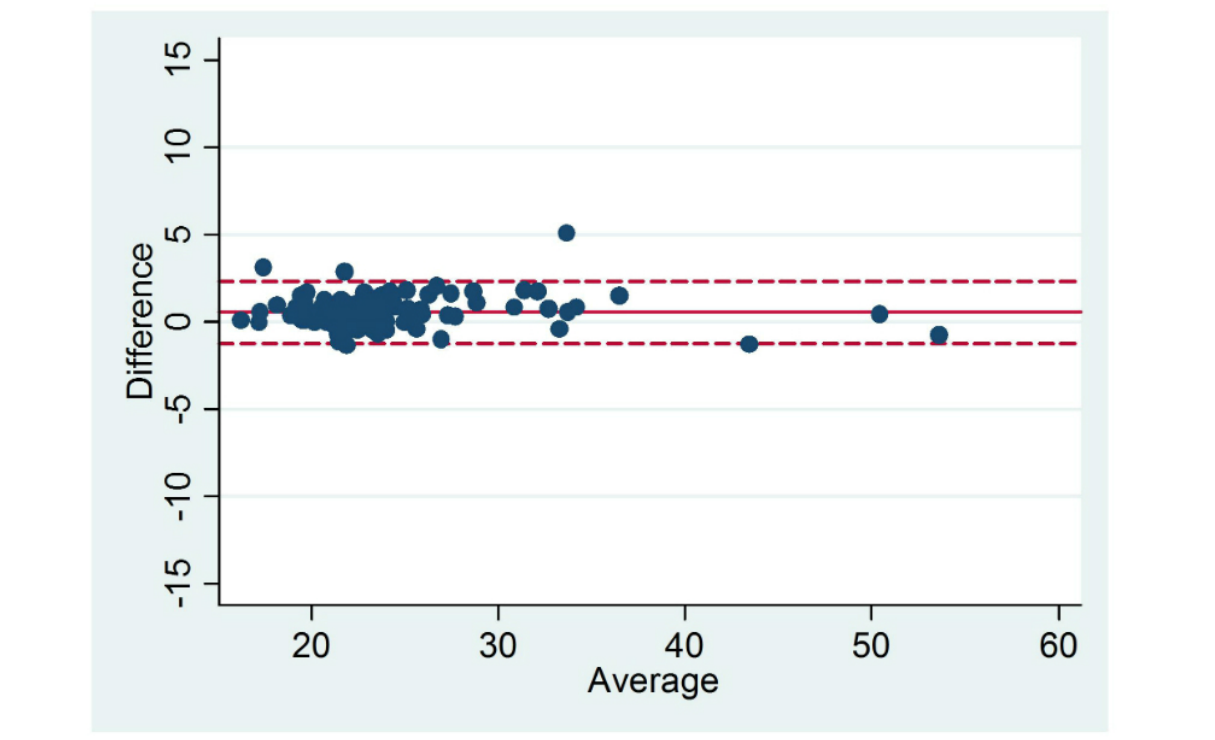
Figure 3. Level of agreement between BMI calculated from self-reported and measured data (kg/m 2 ). Solid line represents the mean difference and dotted line represents the limits of agreement